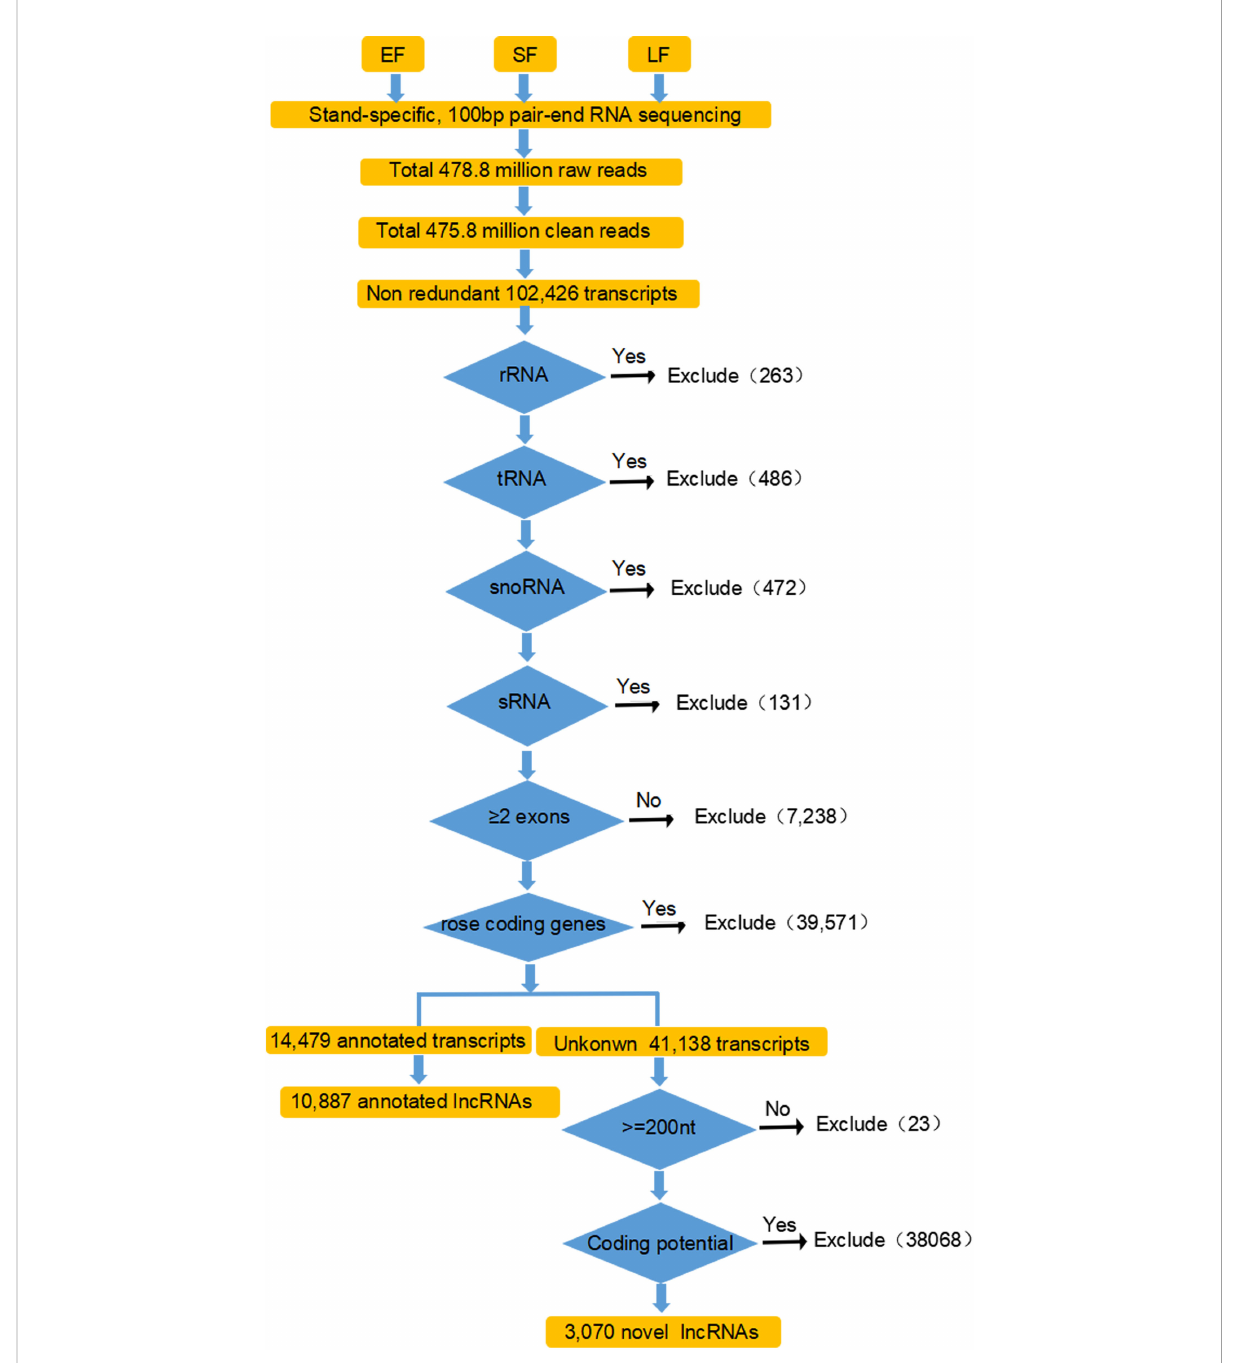
FIGURE 3 Detailed fl ow schematic for identi fi cation of rose lncRNAs. Paired-end strand-speci fi c RNA-Seq was performed for rose fl owers at the EF, SF and LF stages. Clean reads were mapped and assembled according to the known rose genome using Hisat2 and StringTie. Transcripts were fi ltered with the fi ve criteria for the identi fi cation of putative lncRNAs. (i) not housekeeping ncRNAs; (ii) number >2 exons; (iii) not rose coding genes; (iv) length >200 nucleotides and ORF <100 amino acids; and (v) not encoding known protein domains and little coding potential. At each step, a blue arrow indicates those transcripts which were passed by the fi lter; a black arrow, those that were excluded. The number of transcripts that did not pass the fi lter is